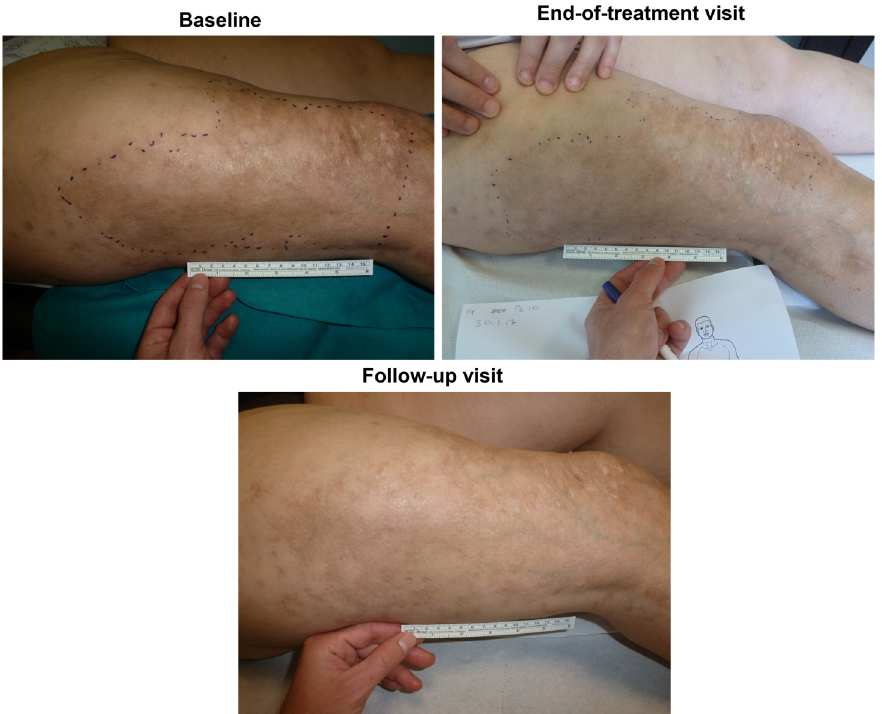
Figure 7. Clinical photograph of a patient (progressive patient no. 10) showing the benefits of a three ‐ month PDRN treatment after 90 and 180 days (“End ‐ of ‐ treatment visit” and “Follow ‐ up visit”, respectively) vs. baseline (“Screening visit”). Photographs owned by the authors with the patients’ permission of use.